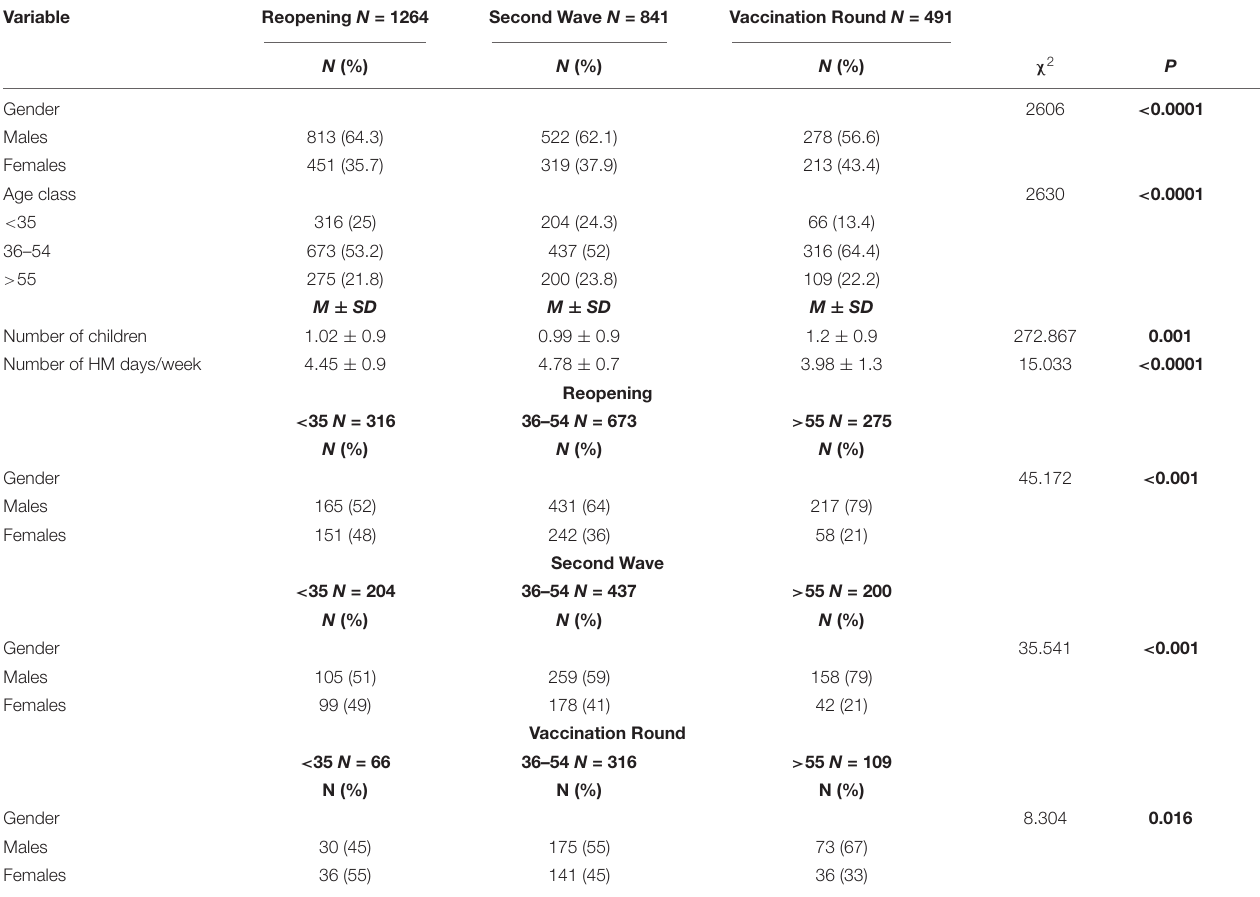
TABLE 1 | Demographic characteristics in Reopening, Second Wave, and Vaccination Round